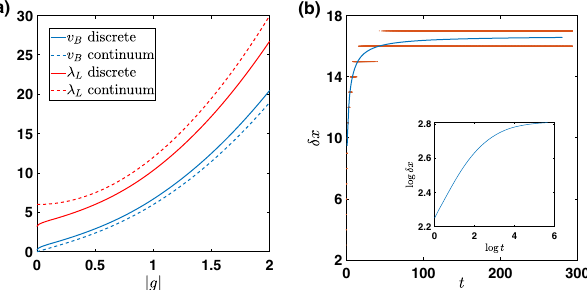
FIG. 6. (a) The difference of v and λ between the discrete B L infinite- N BCC and the continuum approximation. (b) Direct simulation of the discrete model by numerically solving the differential equation (B1). The spatial distance between two contours of log C ð r; t Þ saturates in the late time, showing that the front is sharp. On a log-log plot, the slope of the curve decreases to zero. This result is in sharp contrast to the local Hamiltonian systems, where the slope increases to 1 = 2 and 1 = 3 for the chaotic case and noninteracting case, respectively, as shown in Figs. 4 and